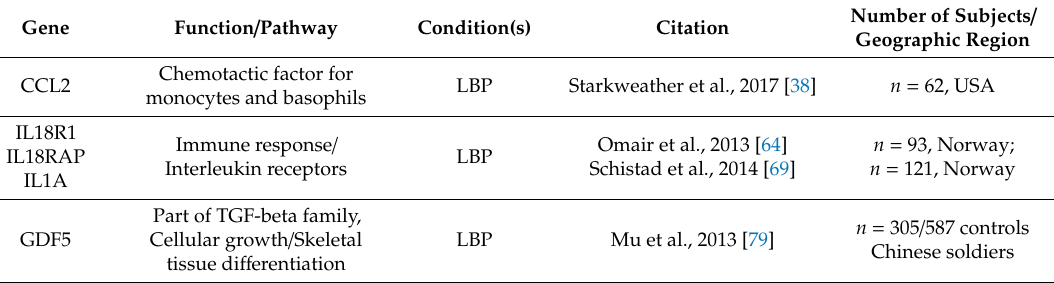
Table 3. Genes related to cytokines and their associated